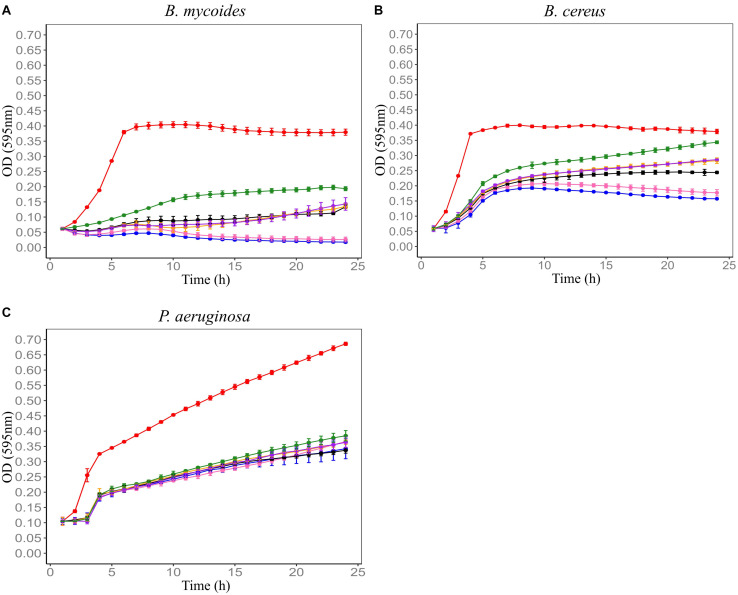
Influence of heat on the antimicrobial activity of Farm 4 soil conditioned medium (F4SCM) against B. mycoides ATCC 6462 (A), B. cereus NZRM 5 (B), and P. aeruginosa ATCC 25668 (C). Bacteria were grown in the presence of butterfield’s diluent (red), F4SCM (blue), F4SCM treated at 50°C for 10 min (pink), F4SCM treated at 70°C for 10 min (black), F4SCM treated at 80°C for 10 min (orange), F4SCM treated at 90°C for 10 min (purple), and F4SCM treated at 90°C for 20 min (green) in the growth media (CMGS). Each curve represents the mean growth rate ± S.D (n = 3). Antimicrobial activity against B. mycoides and B. cereus was significantly decreased following heat treatment at 70°C or higher and there was no significant loss of activity against P. aeruginosa following various heat treatments (p < 0.05 vs. untreated control/F4SCM).